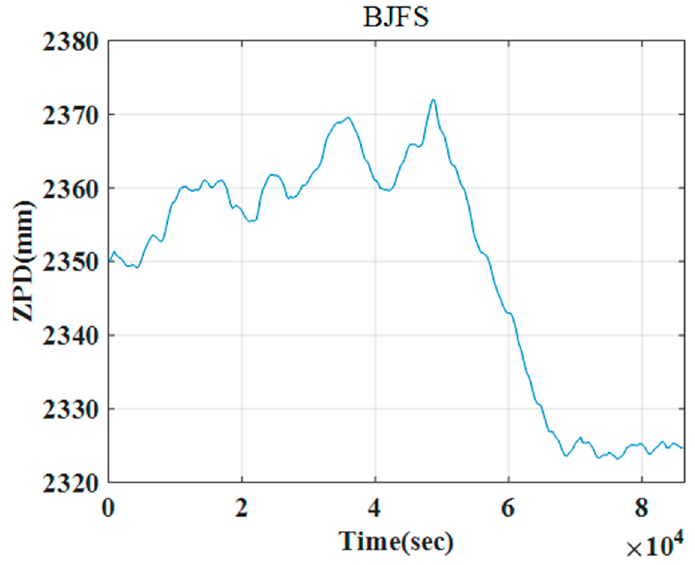
Figure 3. The zenith path delay (ZPD) at the BJFS IGS station on 20 December 2018.